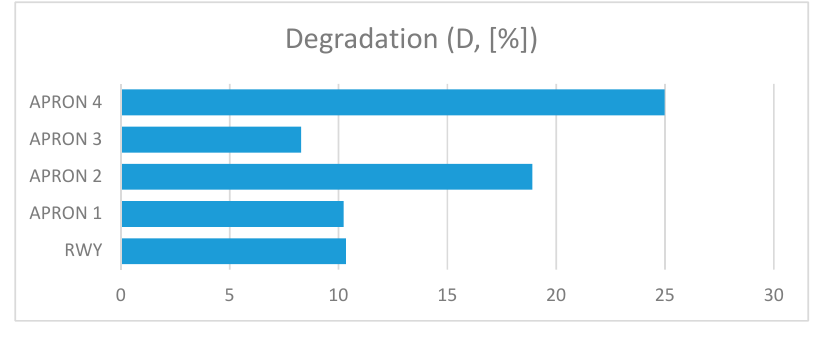
Figure 6. Degradation of AFE’s.